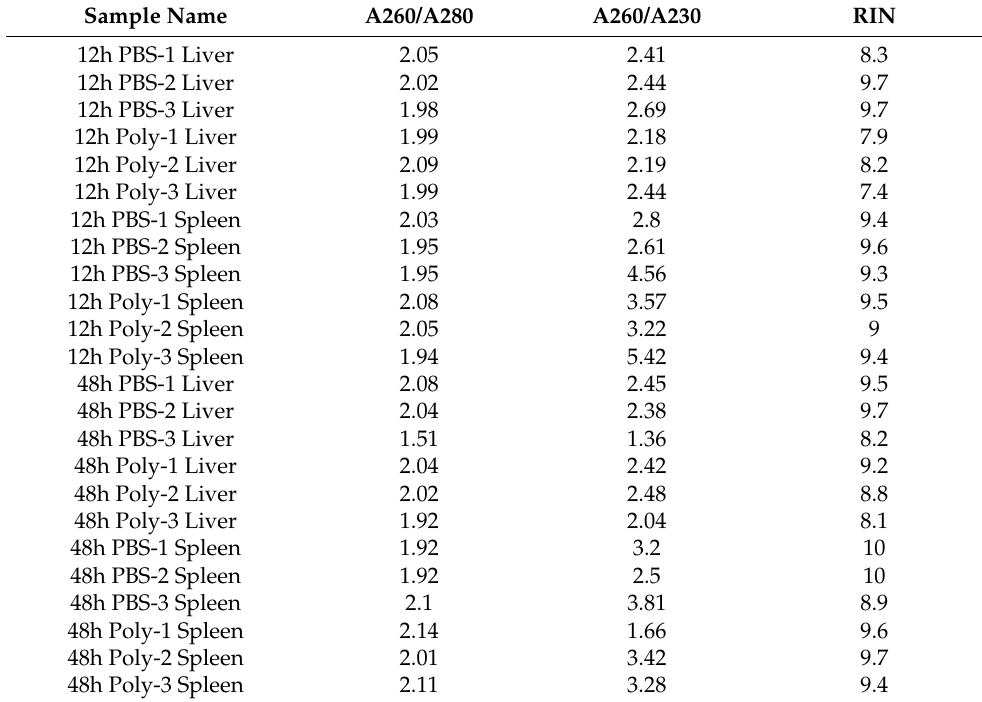
Table 4. The Quality-inspection Results of All RNA